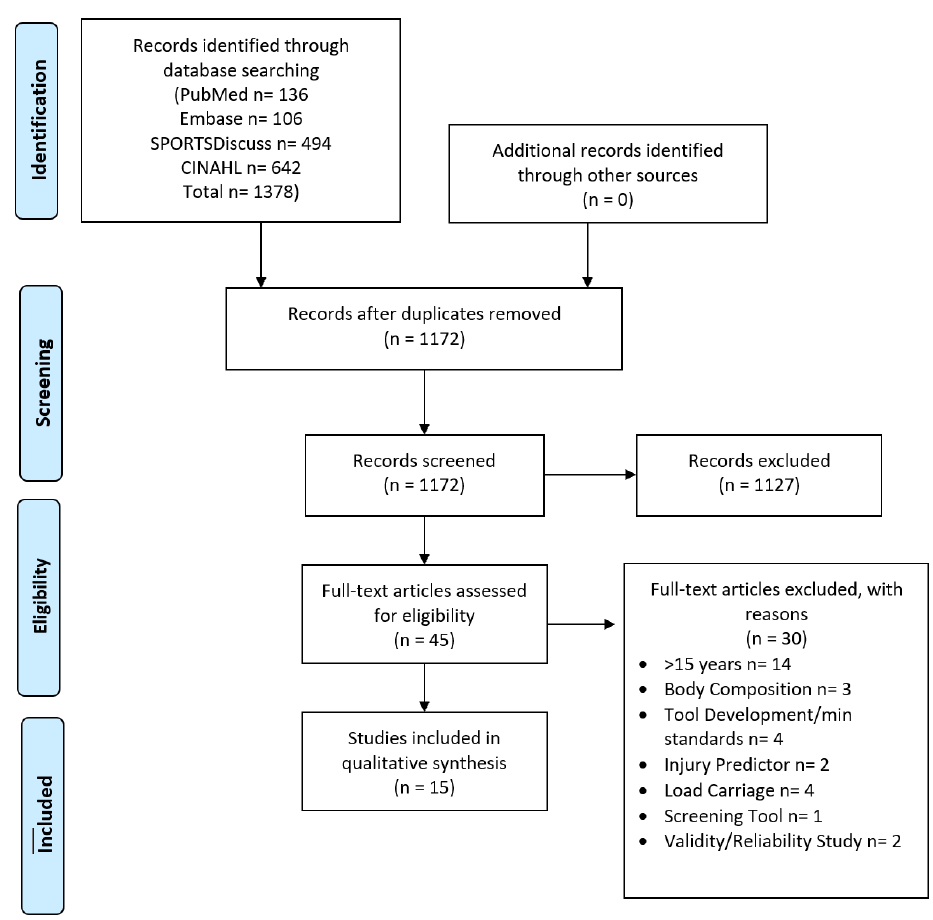
Figure 1. PRISMA [26] diagram summarizing the selection and screening process of the critical review.